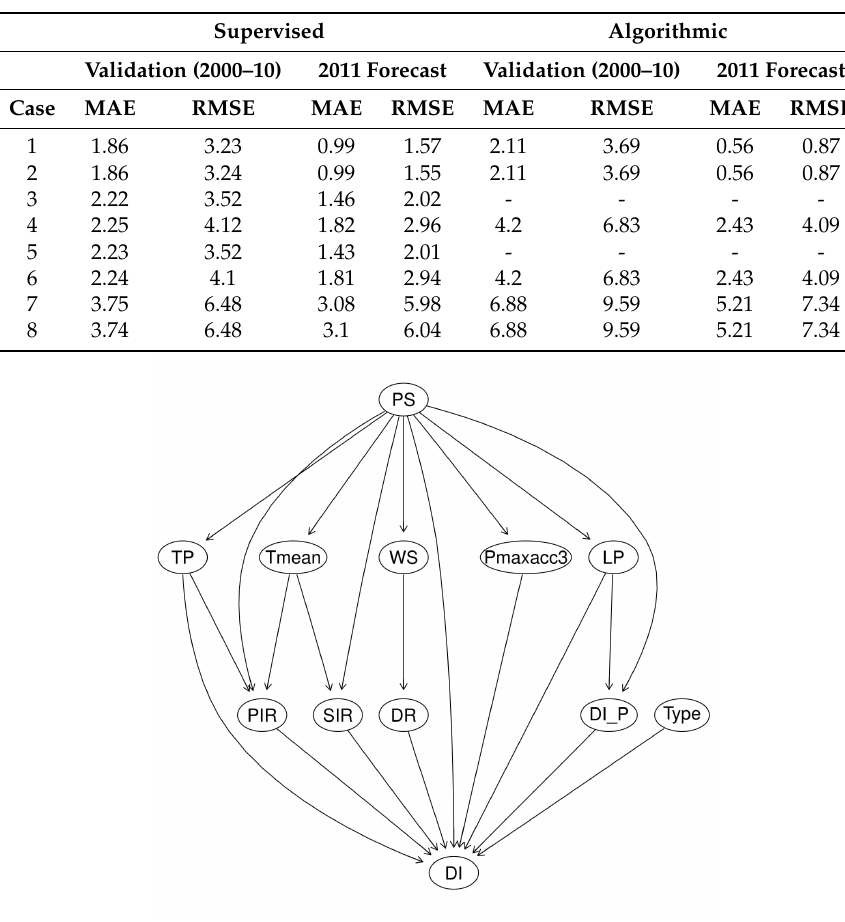
Table 4. Comparison of model performance of parameter learning starting from the first disease date for 8 subsets of network random variables. Forecast skill (MAE and RMSE) from k -fold cross-validation is listed. Smaller and non-negative values in both MAE and RMSE indicate higher model performance. The dash “-” indicates there is no available model for forecasting DI using the selected network random variables.